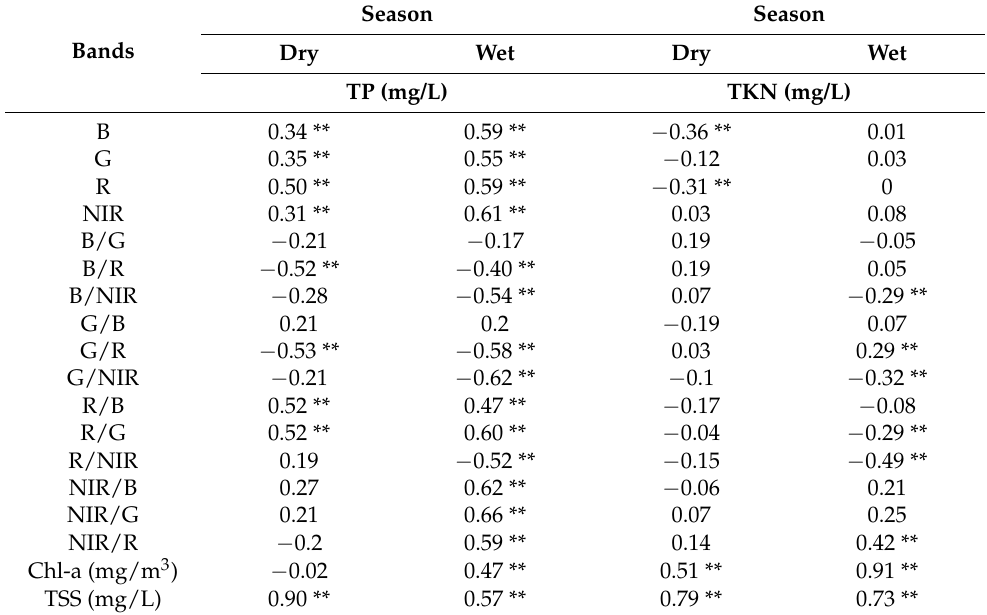
Table 5. Pearson’s R correlation for the in-situ water quality parameters and Landsat bands and ratios.